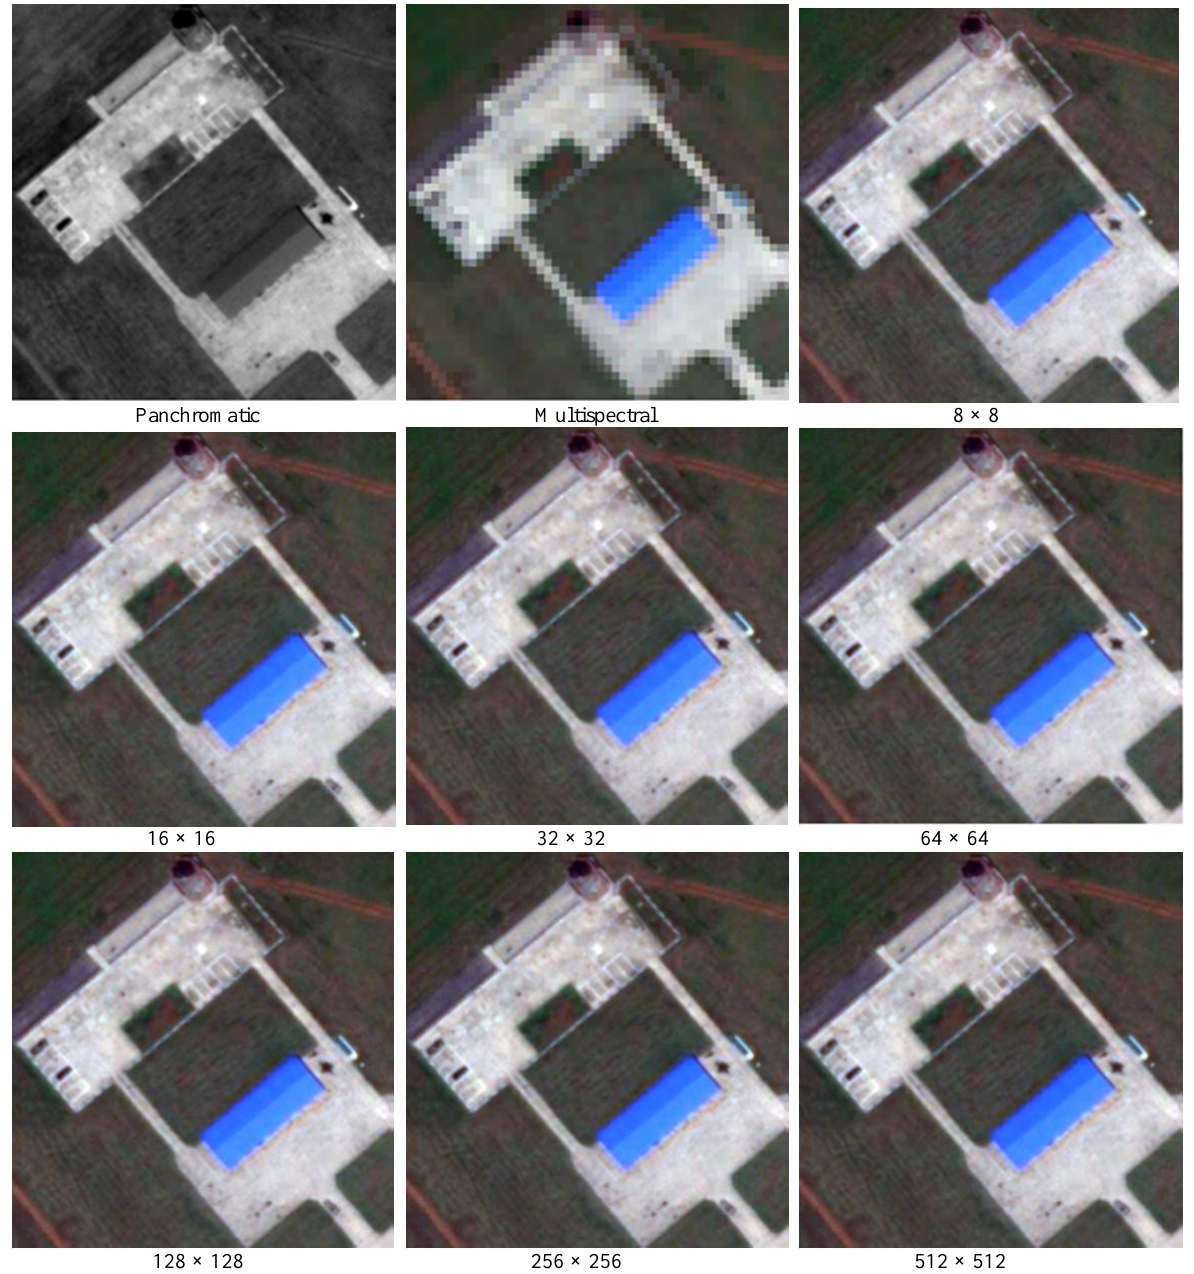
Figure 1. Pan-sharpened Worldview-2 images using BR with different block size (color composites of band 5, 3, and 2, true color for display, display scale 1:1, the result of 1024 × 1024 is not shown because of page